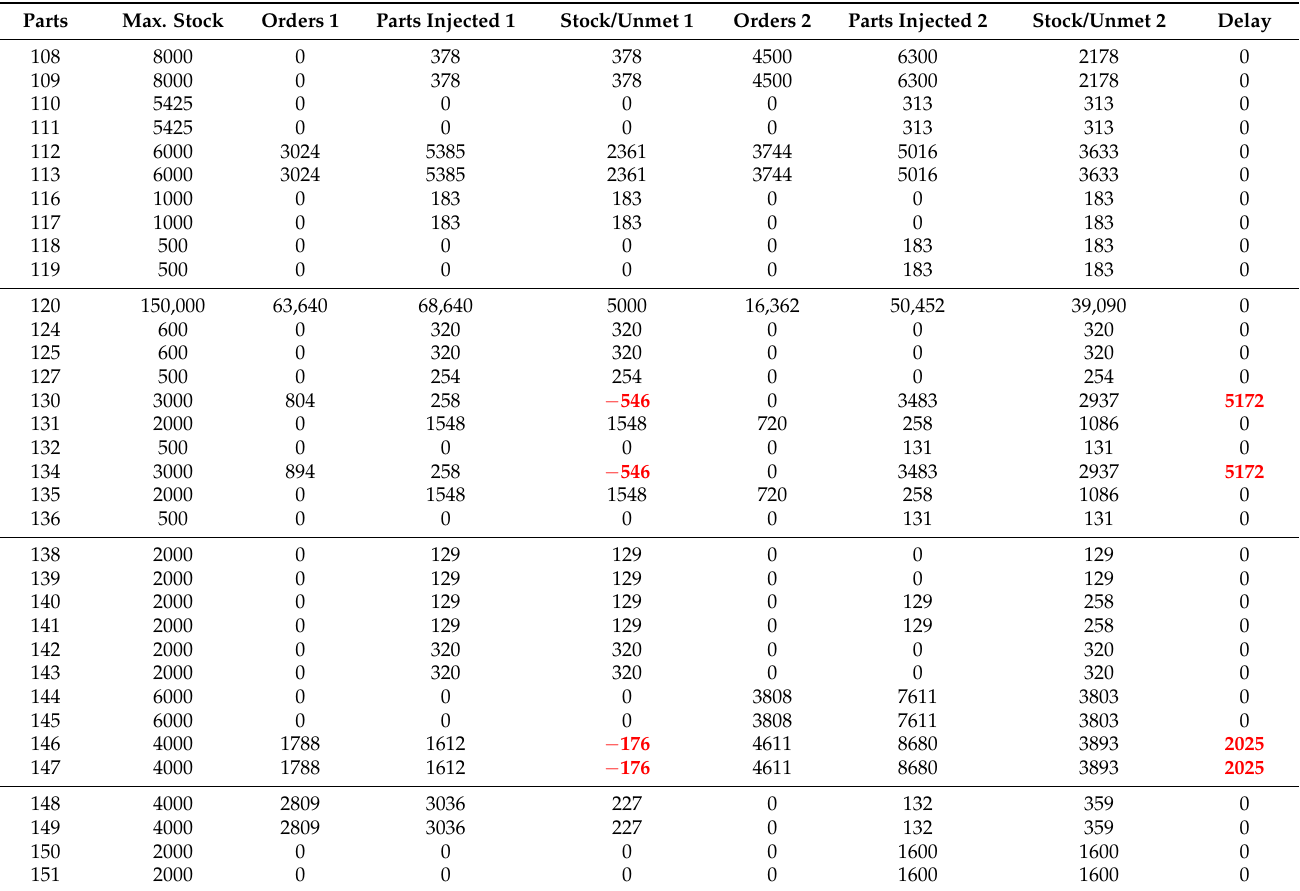
Table 3. Optimal solution